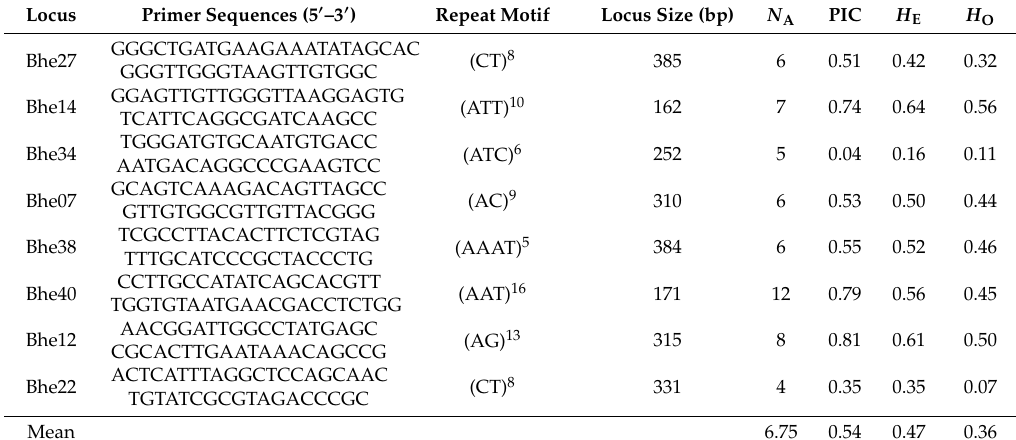
Table 2. Characteristics of eight microsatellite loci across 18 populations of C. hemipterus . Locus Primer Sequences (5 (cid:48) –3 (cid:48)